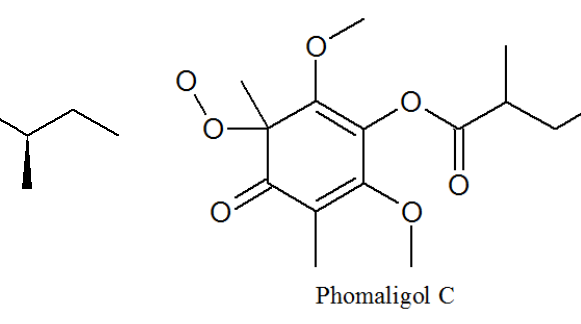
Figure 6. The structures of phomaligols.